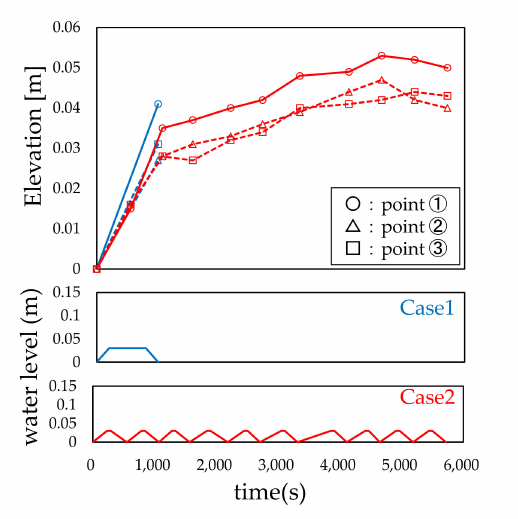
Figure 7. Local scour depth of Cases 1 and 2.